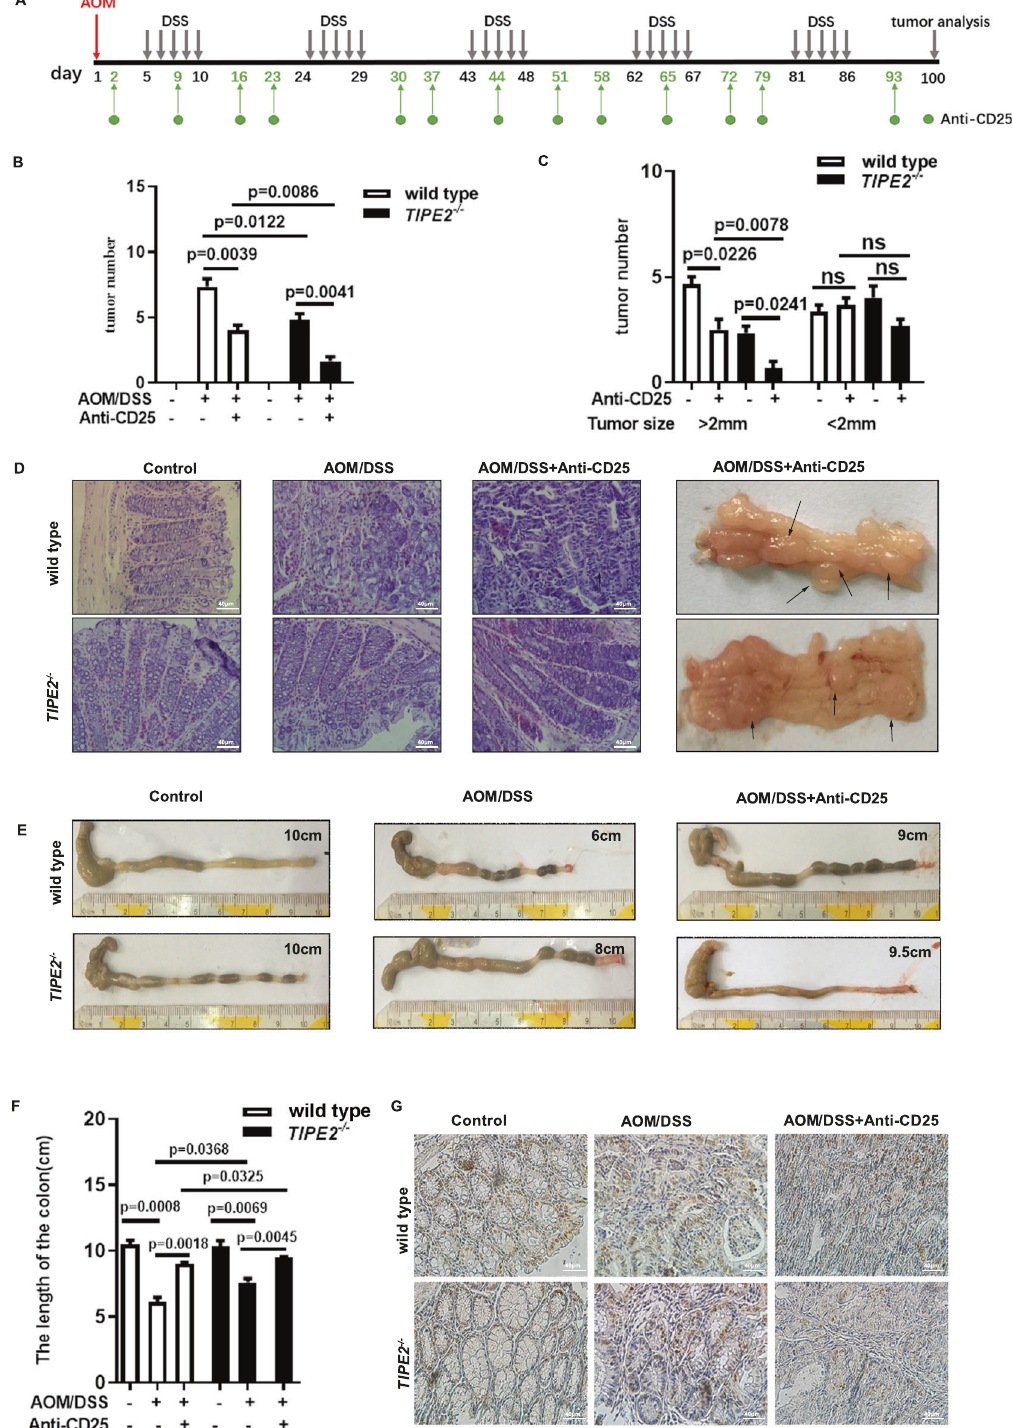
Fig. 6 Tipe2 -de fi ciency was susceptible to anti-CD25-induced Treg depletion. A The used protocol in the experiment. The total tumor number ( B ) or tumors less than 2mm in diameter ( C ) was signi fi cant lower in Tipe2 -de fi cent AOM/DSS models, especially in models with anti-CD25 treatment. Tipe2-de fi ency showed less severe intestinal in fl ammation ( D ) accompanied by longer length of the colon ( E and F ) in AOM/DSS models, especially with anti-CD25 treatment. G The BrdU positive cells decreased in Tipe2-de fi cent AOM/DSS models, especially with anti-CD25 treatment. Signi fi cant difference between two groups was determined using an unpaired two-tailed Student ’ s t -test. * P <0.05, ** P <0.01, *** P decreased signi fi cantly. Cells with Tipe2 overexpression are that the overexpression of Tipe2 markedly downregulated the inclined to senescent phenotype. These data further con fi rm the expression of c-Myc and c-Ets-2, which are important regulators notion that the overexpression of Tipe2 plays suppressor role in for hTERT transcription [30, 31]. Tipe2 also blocks the nucleus tumor cells [20 – 22]. translocation of c-Ets-2. Accordingly, the telomerase activity